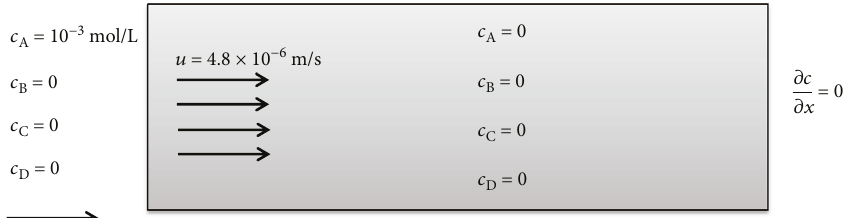
Figure 32: Sketch of domain used for 1D simulation of advection-di ff usion-reaction of four species involved in a chain of decay reactions. The left boundary is maintained at constant concentration for di ff erent species, and the right boundary is a zero concentration gradient.